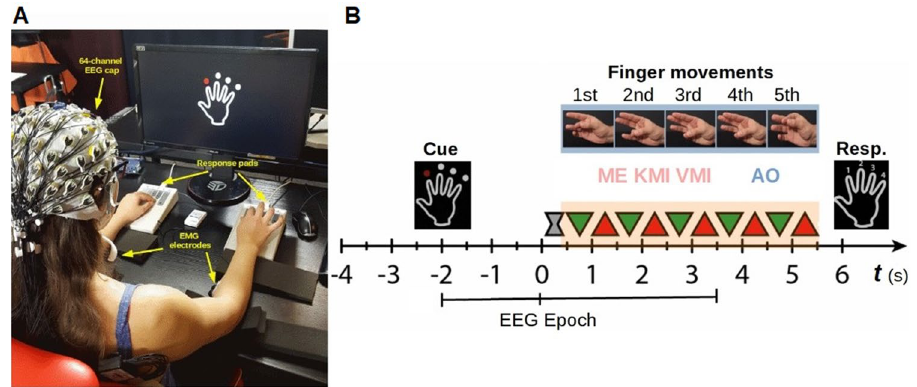
Figure 5. ( A ) Experimental setup and ( B ) procedure. In each block, participants were instructed to observe (AO), execute (ME), or imagine (KMI, VMI) fingers movements of their right or left hand, starting from a finger which was indicated with a red dot. Then the gray hourglass symbol was displayed to indicate the time for preparing to begin the task. During finger movements, a green triangle was presented in the middle of the screen as a signal to contact the fingers and a red triangle as a signal to distance them (ME, KMI, and VMI conditions). In the AO condition, a video sequence with recorded finger movement was displayed instead of triangles. Each trial was composed of three to five movements (randomly). At the end of a sequence, participants were asked to press the button corresponding to the last finger movement. The trial structure was a modified version of the procedure used by Kim et al. 48 . Used software to create the images in this figure: LibreOffice